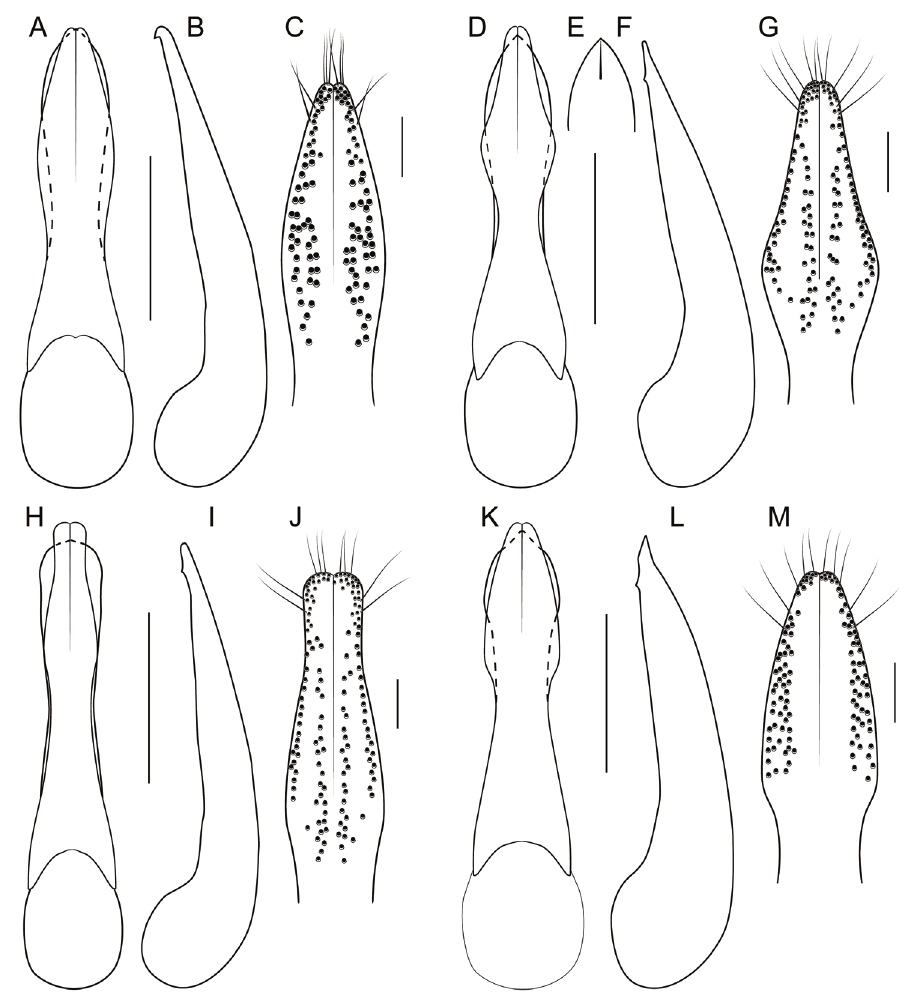
Figure 10. Bolitogyrus caesareus (Bernhauer) ( A–C ), B. proximus (Cameron) ( D–G ), B. temburong (Brunke) ( H–J ) and B. rufipennis (Cameron) ( K–M ). Aedeagus in parameral view ( A, D, H, K ), median lobe in lateral view ( B, F, I, L ), peg setae of paramere ( C, G, J, M ). Scale bars: 0.5 mm ( A–B, D–F, H–I, K–L ), 0.1 mm ( C, G, J, M